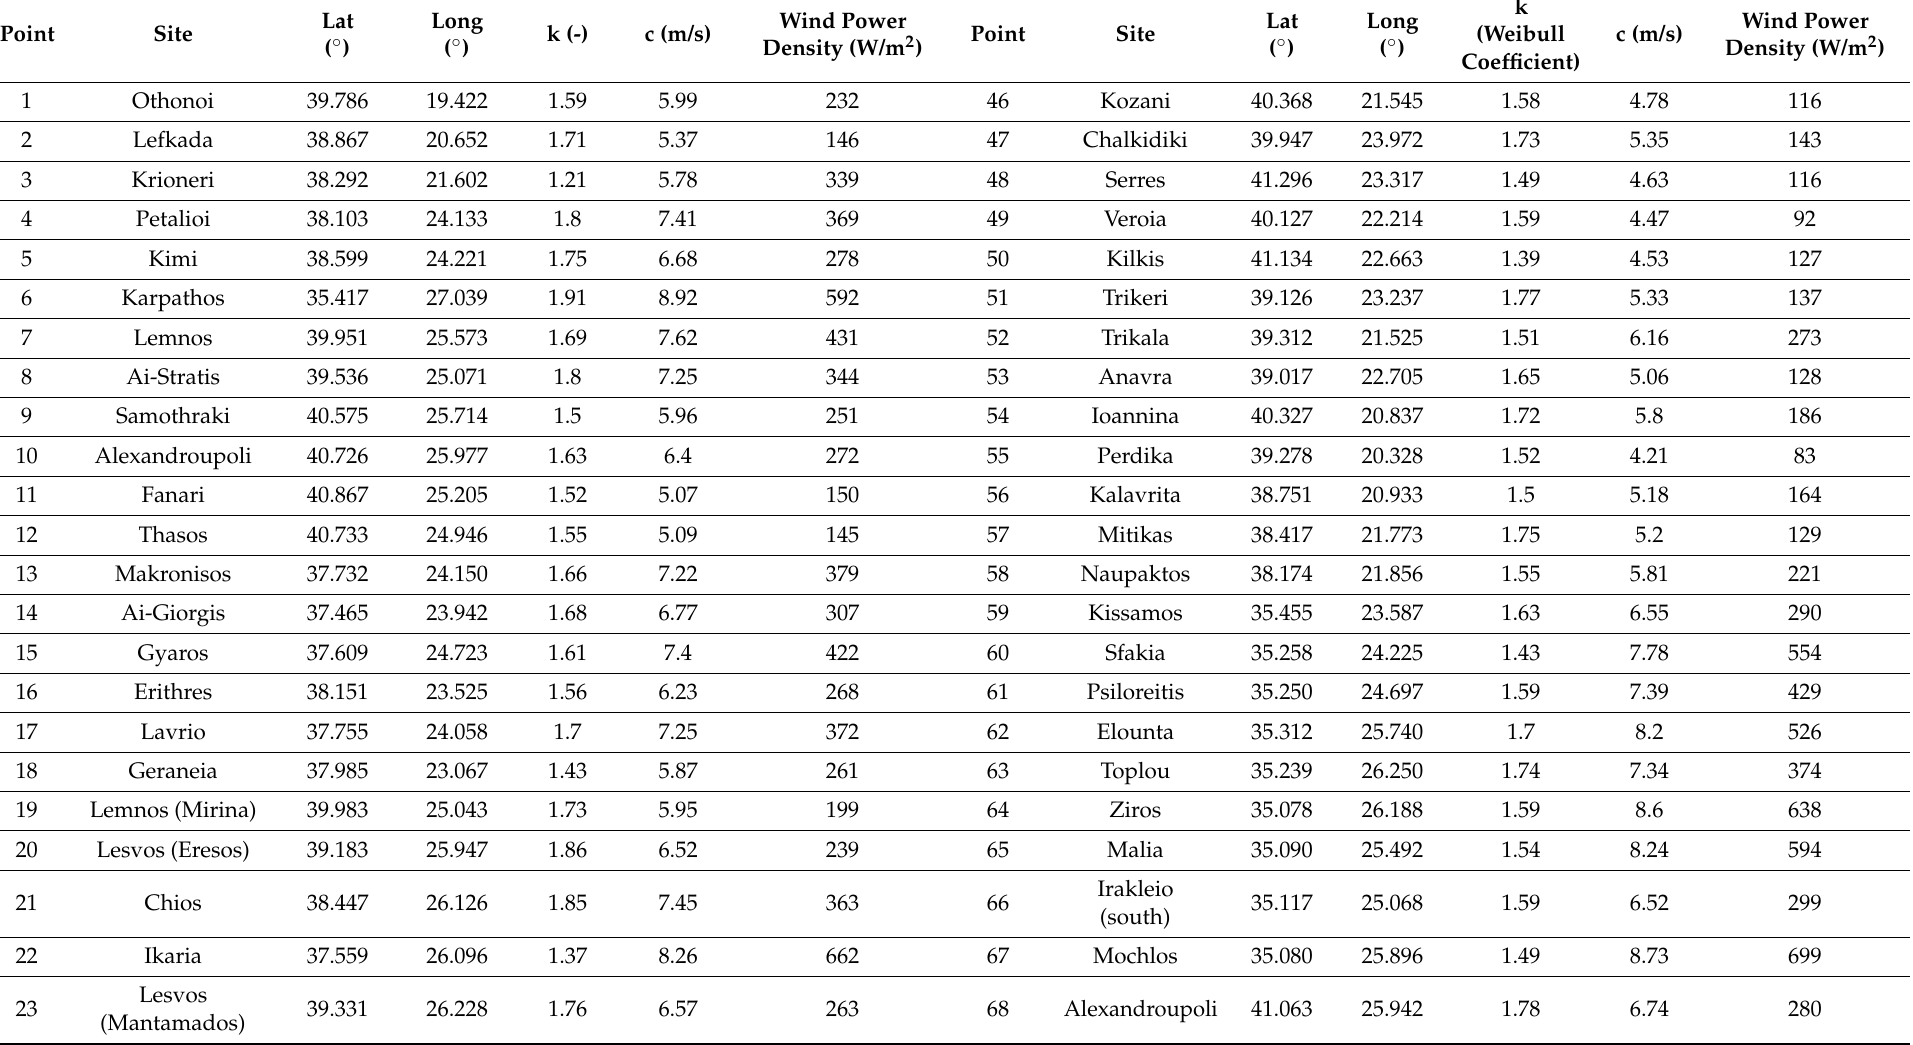
Table 2. Mesoscale typical wind year data of the representative points